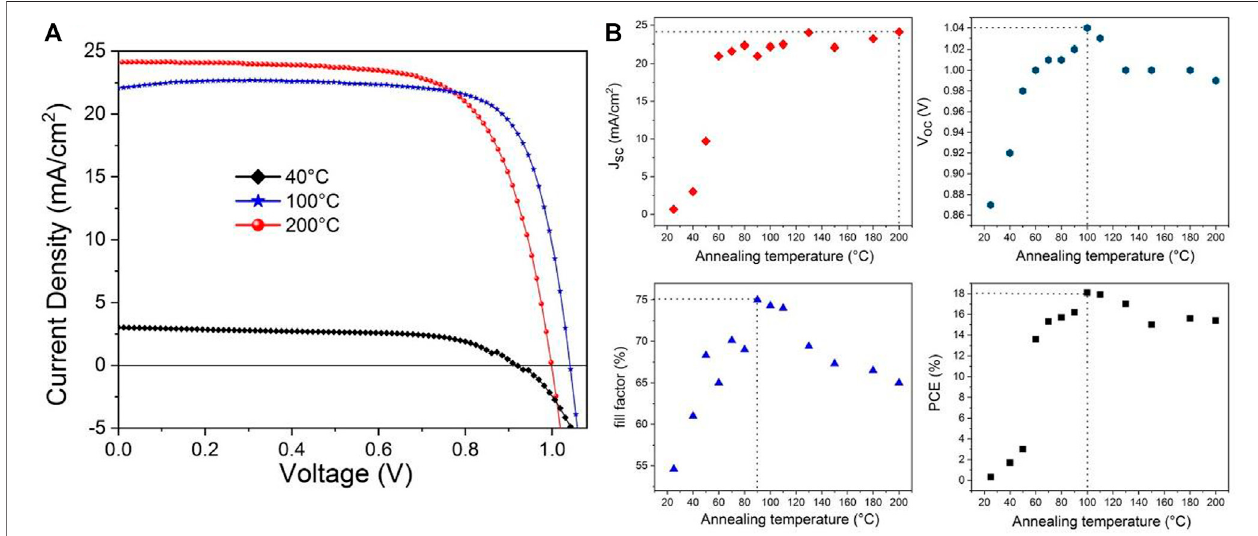
FIGURE 5 | (A) ( J-V ) curve under AM1.5G conditions of MAPbI 3 -based devices with different annealing temperatures: 40 ° C, 100 ° C and 200 ° C, during 30 min. (B) Evolution of the cell characteristics as a function of the annealing temperature of MAPbI 3 . (scan rate: 10 mV s − 1 ; area: 0.09 cm 2 ; without any prior light soaking or pre- treatment applied to the devices).